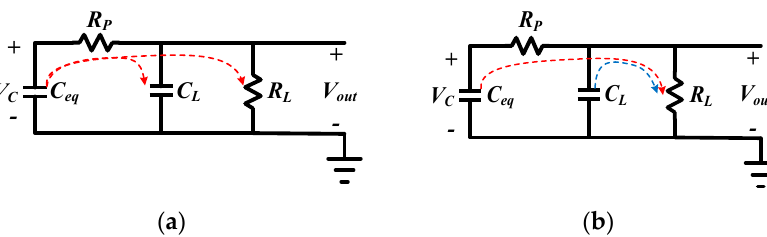
Figure 12. Charge transfer model of 1-bit SSC: ( a ) Charge distribution phase; and ( b ) delivery phase.